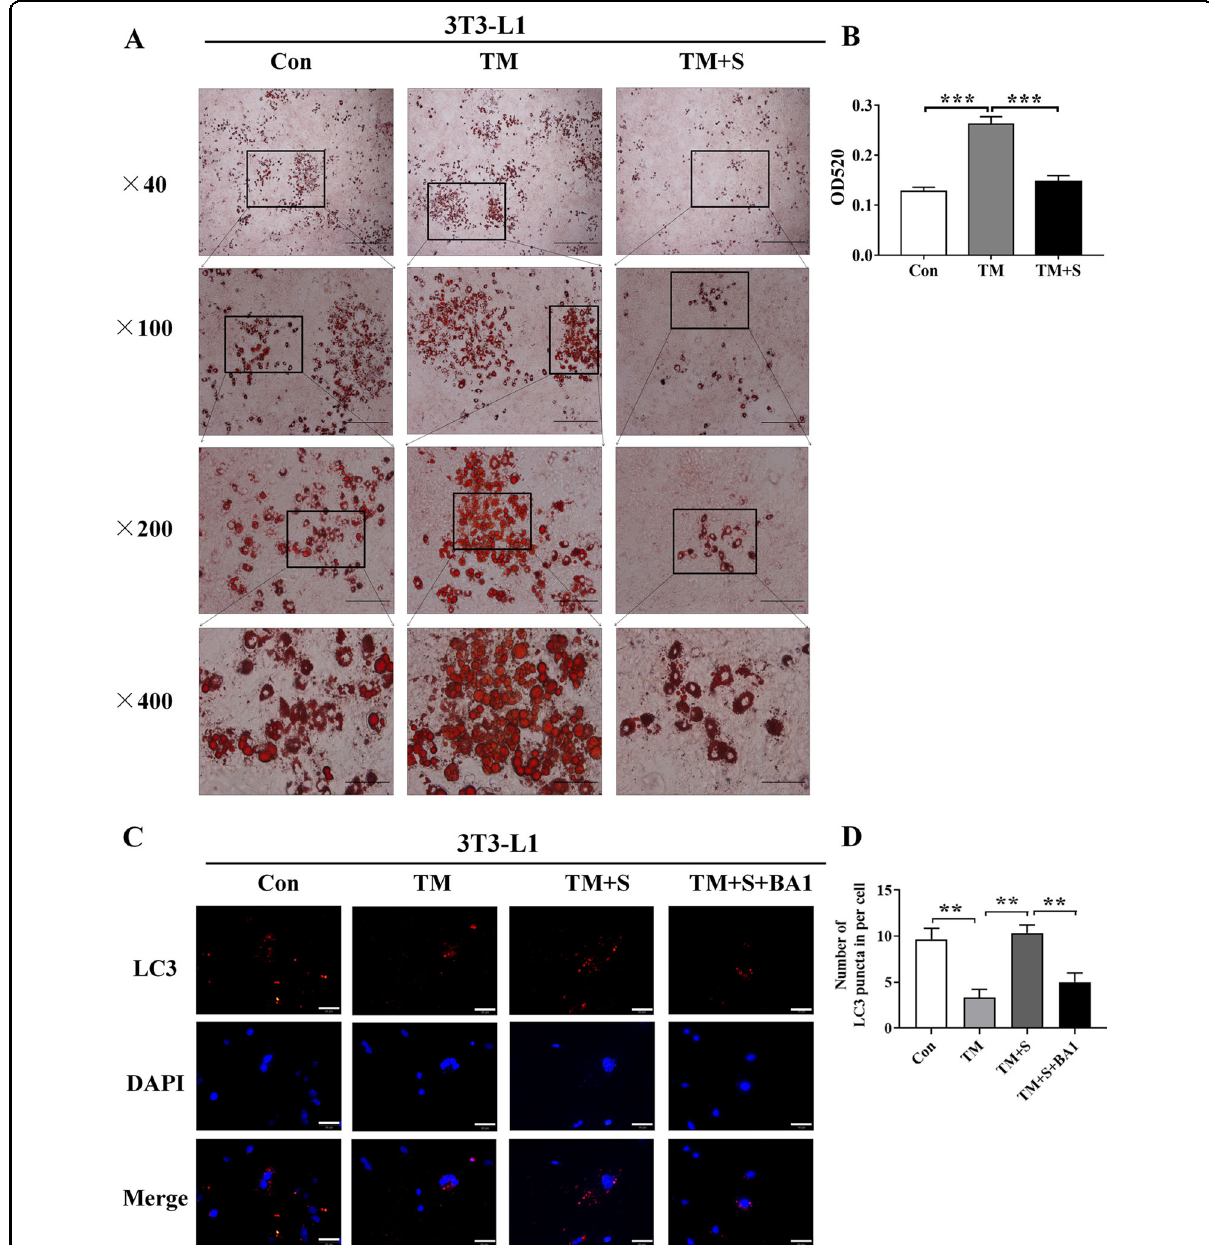
100 μ m; 400×, scale bar = 50 μ m; all graphics were in a blinded fashion). c Representative immuno fl uorescence images of LC3 in 3T3-L1 cells from the four groups (blue: DAPI; red: LC3 + cells; Tm: tunicamycin; Tm + Sal: tunicamycin + salubrinal; Tm + S + BA1: tunicamycin + salubrinal + ba fi lomycin A1; 400×, Bar = 50 μ m). d Quanti fi cation of LC3 puncta per cell was shown. The experiments were conducted in triplicate. The asterisks (*, **, and ***) represent P < 0.05, P < 0.01, and P < 0.001,